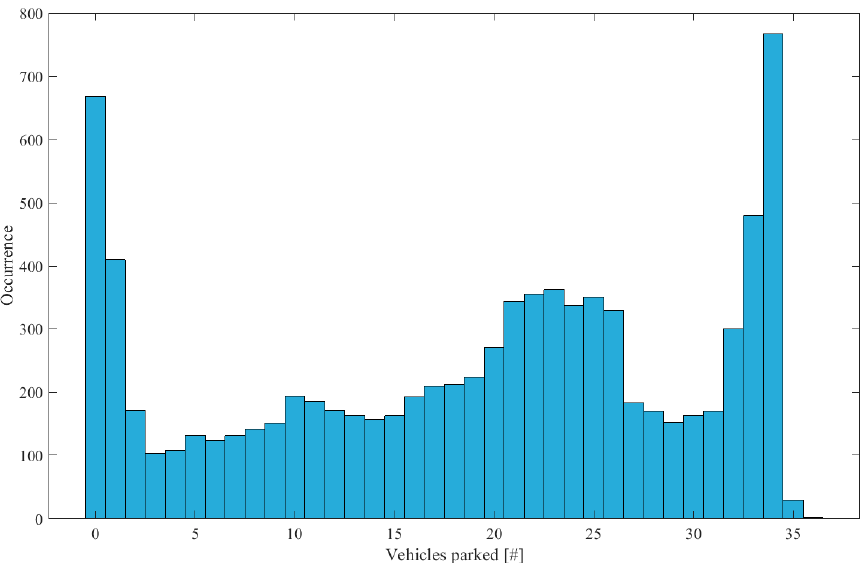
Figure 3. Occurrence of number [#] of vehicles parking simultaneously during one